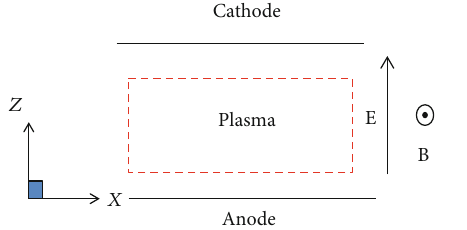
Figure 7: Schematic of electric fi eld and magnetic fi eld in MHD interaction zone.